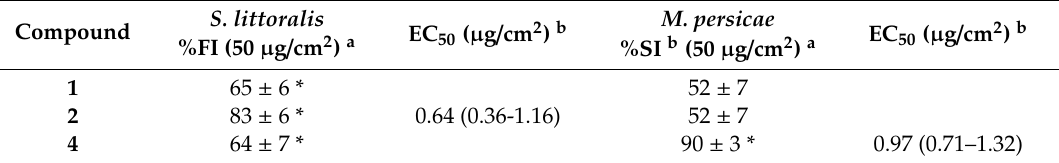
Table 4. Antifeedant activity of S. fistulosus compounds 1 , 2 , 4 .